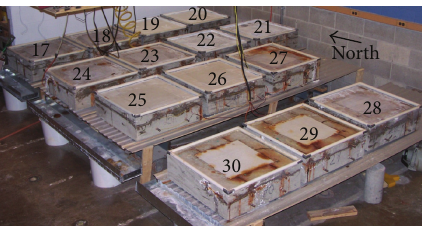
Figure 10: Surface staining on laboratory CoC specimens after 6 months.